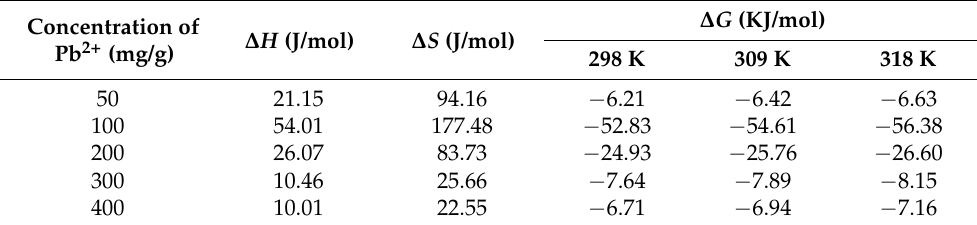
Table 3. Thermodynamic parameters for the adsorption of Pb 2+ on MT-WAO resin. Concentration